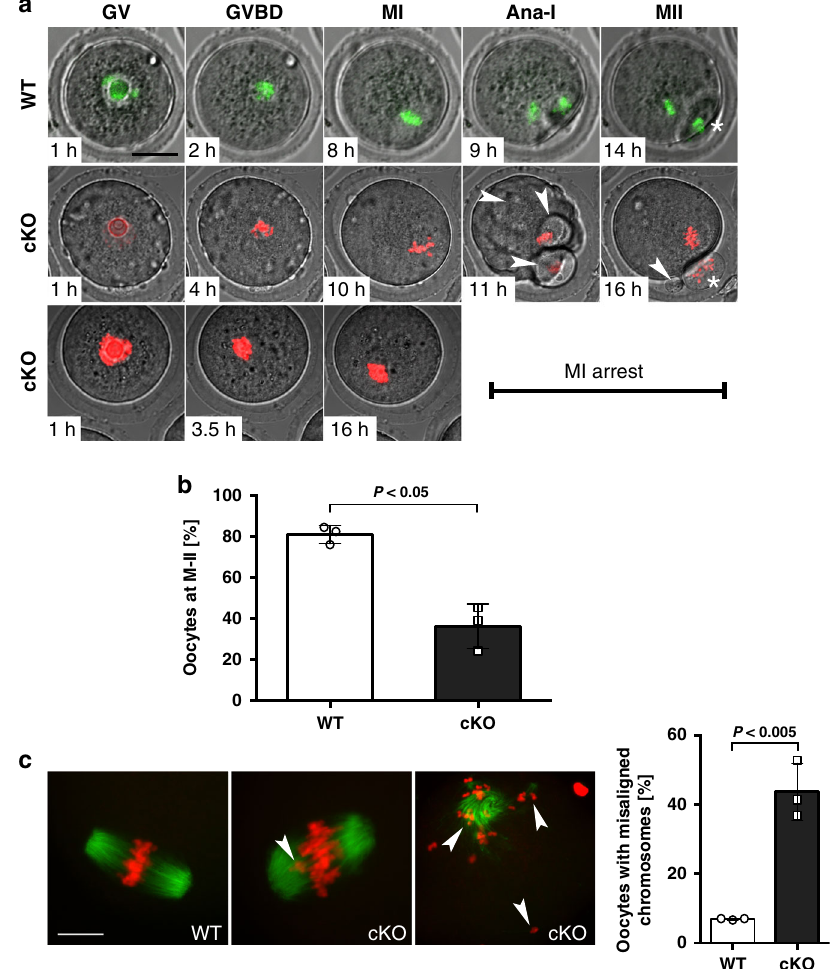
Fig. 5 Conditional deletion of LSH disrupts meiotic progression and chromosome segregation in preovulatory oocytes. a Live-cell imaging revealed a delayed onset of germinal vesicle breakdown (GVBD) in LSH-cKO oocytes and defects in oocyte maturation including membrane ruf fl ing (arrowheads), abnormal cytokinesis, and splitting of the fi rst polar body (arrowhead/asterisk) in a subpopulation of oocytes that reached the metaphase-II stage, while some oocytes remained at metaphase-I for up to 16 h of in vitro maturation. Chromosomes in wild-type oocytes were labeled with recombinant histone H2B-GFP (green), cKO oocytes were microinjected with H2B-RFP (red). Scale bar (40 μ m). b Proportion of oocytes reaching the metaphase-II stage in wild-type ( n = 218) and cKO ( n = 198) oocytes. LSH knockout induced a signi fi cant reduction in oocyte maturation to the metaphase-II stage. Data are shown as the mean ± SD of three independent replicates. Statistical analysis was performed using unpaired t -tests, two tailed and resulted in P = 0.0027. c Mutant oocytes exhibit chromosome congression defects at metaphase-I (arrowhead) and meiotic spindle instability at the metaphase-II stage (arrowheads) resulting in a signi fi cant increase in the proportion of in vitro matured oocytes with misaligned chromosomes. Chromosomes were stained with DAPI and pseudo colored in red and microtubules were stained for acetylated tubulin (green). Data are presented as the mean ± SD of three replicates with wild-type ( n = 86) and cKO ( n = 84) oocytes. Scale bar (15 μ m). Statistical analysis was performed using unpaired t -tests, two tailed and resulted in P =